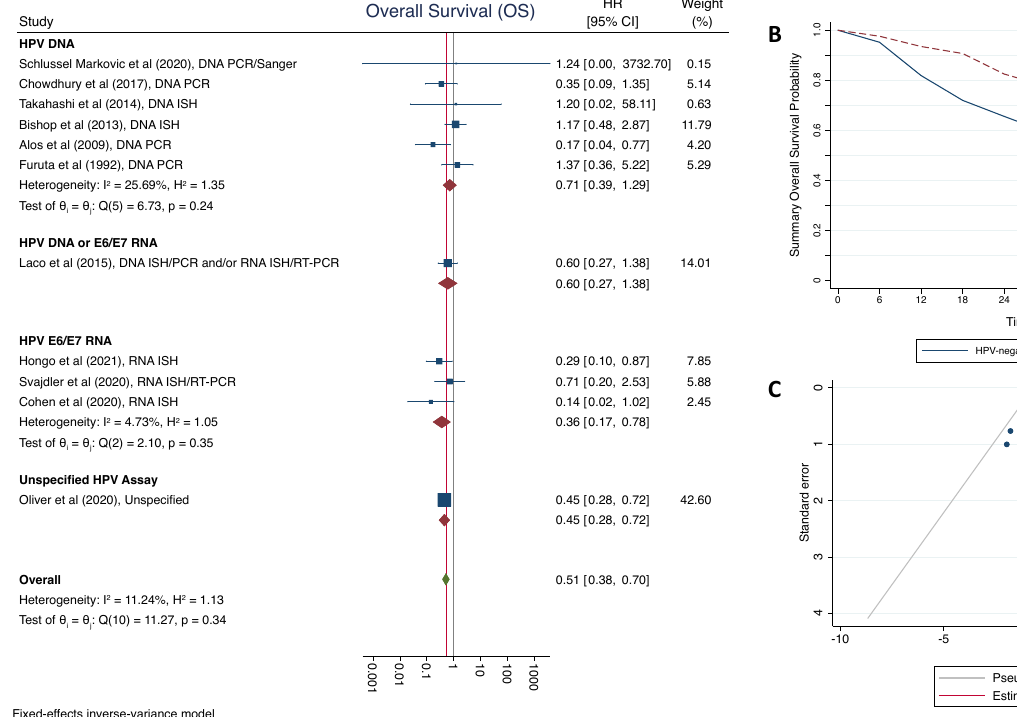
Figure 2. Summary estimates for the association between human papillomavirus (HPV)-status and overall survival (OS) for patients with sinonasal squamous cell carcinoma (SNSCC): ( A ) forest plot of overall survival meta-analysis with summary hazard ration (HR) stratified by HPV detection method; ( B ) summary Kaplan-Meier curve for 5-year OS of SNSCC patients by HPV status with log-rank p -value for differences between curves; ( C ) funnel plot for Egger test to assess evidence of bias due to small study